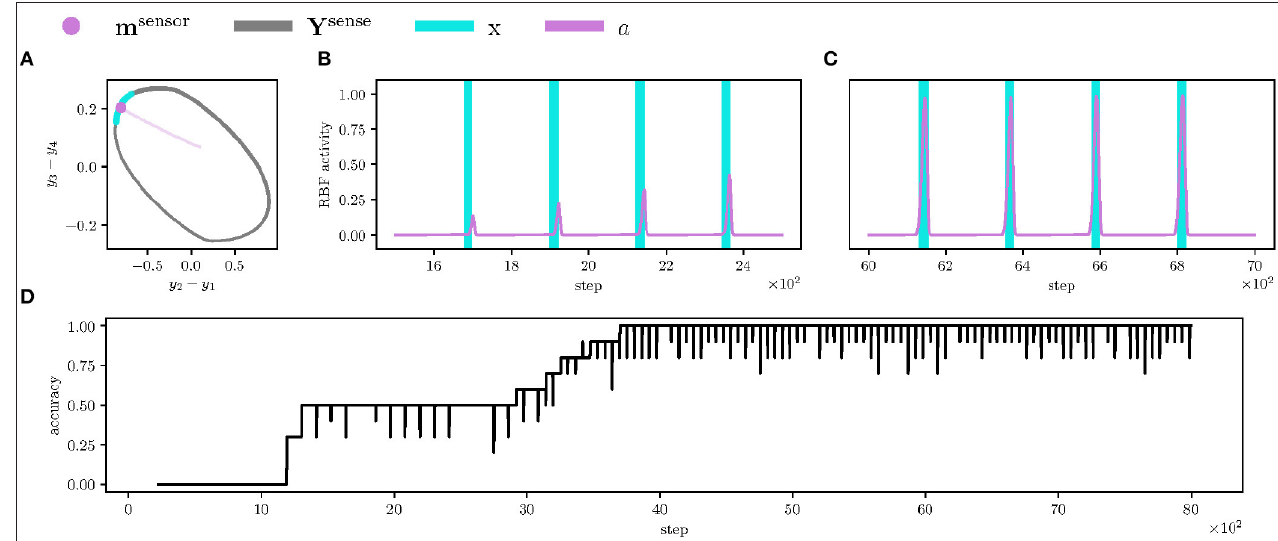
FIGURE 8 | Detail of learning the left leg’s contact event anticipation and the overall anticipation accuracy. (A) Projected CPG limit-cycle Y sense (in the gray) and the event RBF weight m sensor trajectory (in the magenta) of the front left leg’s contact event. During the learning, the RBF weight approaches the limit-cycle segment, during which the left leg senses contact x > 0 (in the blue). At the end of the learning, the RBF weight (the magenta dot) is close to the limit-cycle segment; therefore, the RBF activity a spikes during the phase segment can be seen in the following plots. (B) At the start of the learning, the RBF activity a (in the magenta) is low and peaks outside of the left leg contact event x > 0 (in the blue). (C) However, at the end of the learning, the RBF activity peaks are close to the maximum possible activity (one), and the peaks overlap with the events. Ideally, the total number of such overlaps during one gait-cycle is twelve, one per each sensory input. (D) The plotted sum of the anticipation-event overlaps over a sliding window of the size T gait = 223 divided by the number of sensory inputs (12). At step 4,000, all RBF neuron anticipations overlap with the measured sensory events.